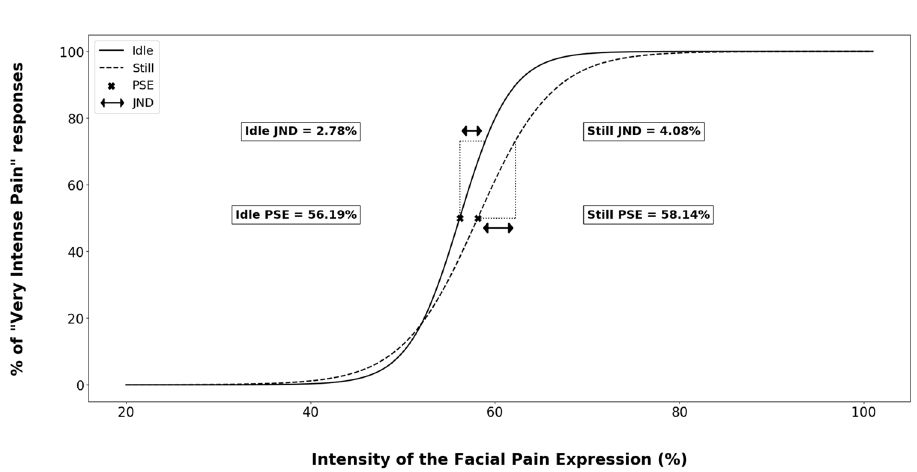
Figure 2. Logistic modelling of “Very Intense Pain” responses according to facial pain expression intensity in the still and idle conditions . PSE and JND correspond to the mean of PSE and JND obtained from the modelling of each participant.